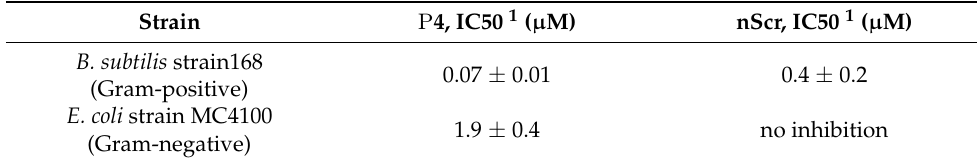
Figure 3. The effects of the “scramble” peptide nScr on the viability (colony-forming activity) of the exponentially growing E. coli ( a , b ) and B. subtilis ( c , d ) cells after 1-h exposure. Representative experiments are shown. Graphs in ( b , d ) are the peptide nScr dose–response curves that were plotted for the experiments that are illustrated in panels ( a , c ), respectively; the number of colonies in the absence of the peptide is taken as 100%. * The difference from the control value is statistically significant at p ≤ 0.05. Table 1. The antibacterial effects of peptides P4 and nScr on the cell growth of the model strains of E. coli and B. subtilis